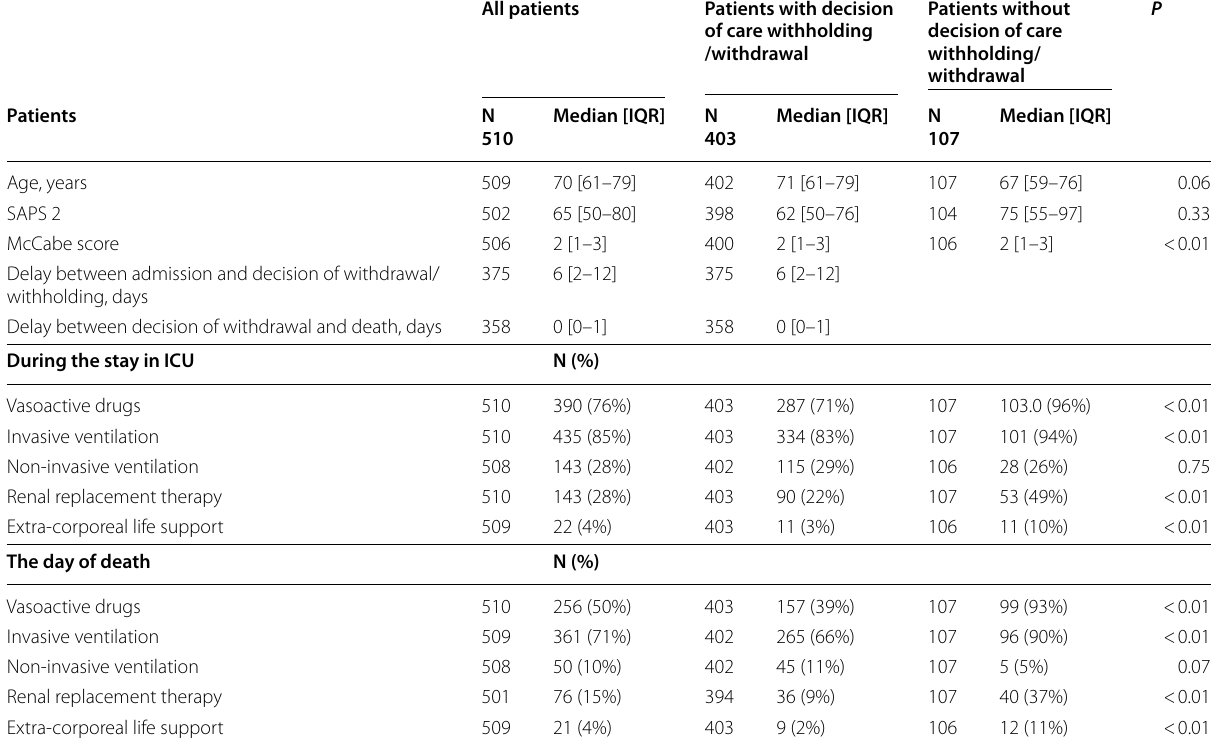
Table 1 Characteristics of patients